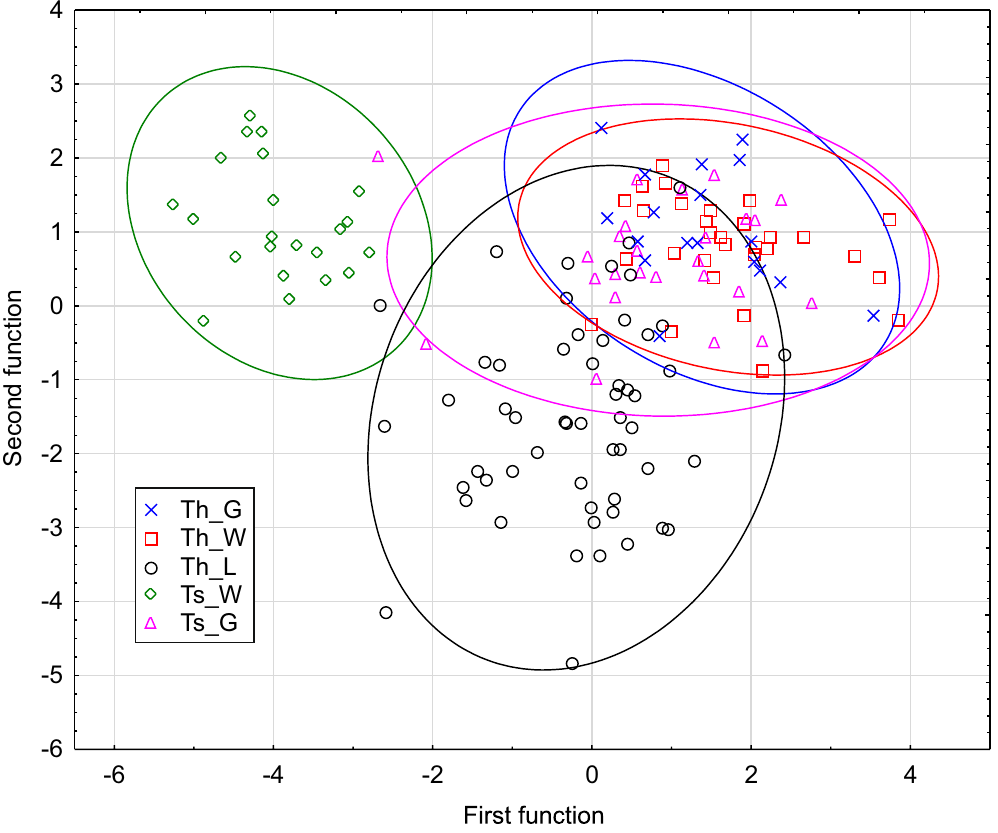
Figure 6. Discriminant function analysis plot for five groups of Trochulus : parental T. hispidus from wild habitat in Wrocław (Th_W), the first generation of T. hispidus raised in laboratory (Th_L); T. hispidus bred in garden in Wrocław (Th_G); T. sericeus from wild habitat in Muszkowice (Ts_W); T. sericeus bred in garden in Wrocław (Ts_G).